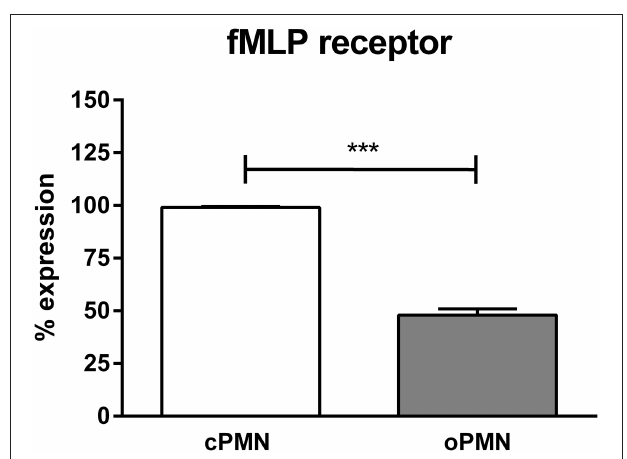
FIGURE 3 | fMLP receptor expression by cPMNs and oPMNs. Quantitative analysis of fMLP receptor expression (percentages) of cPMNs (white bar) and oPMNs (gray bar). The gating strategy as presented in Supplementary Figure 2 was followed. Data are presented as mean ( + SEM) percentages of fMLP receptor expression of the live, CD16 + population. n = 3, *** p < 0.0005.